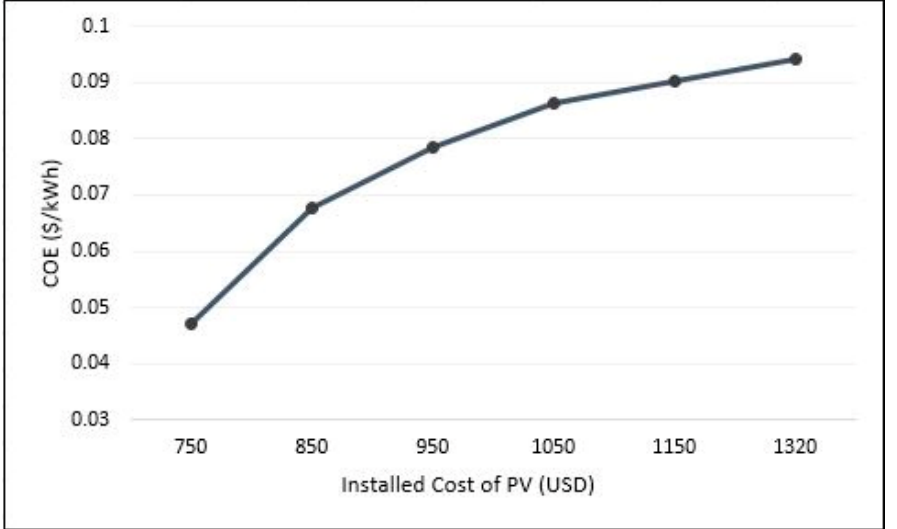
Figure 12. Change of LOCE of the G1 configuration with installed cost of the PV.